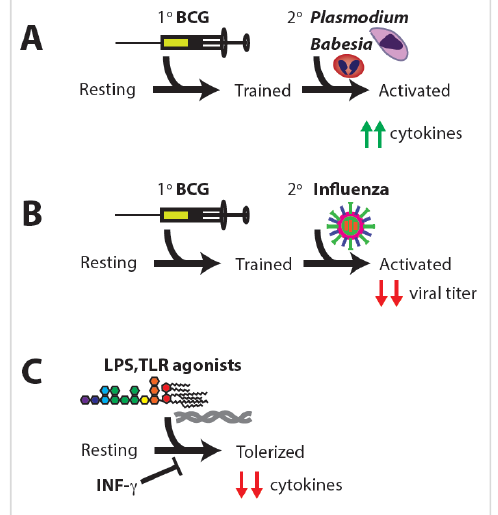
Figure 3. Innate immunity cells can become trained, activated, or tolerized depending on the primary and secondary stimuli. Stimulus with a prokaryotic antigen can cause trained cells that are capable of responding to ( A ) eukaryotic or ( B ) viral secondary stimuli. ( C ) Other stimuli can result in tolerization that can be blocked by pre-treatment with specific